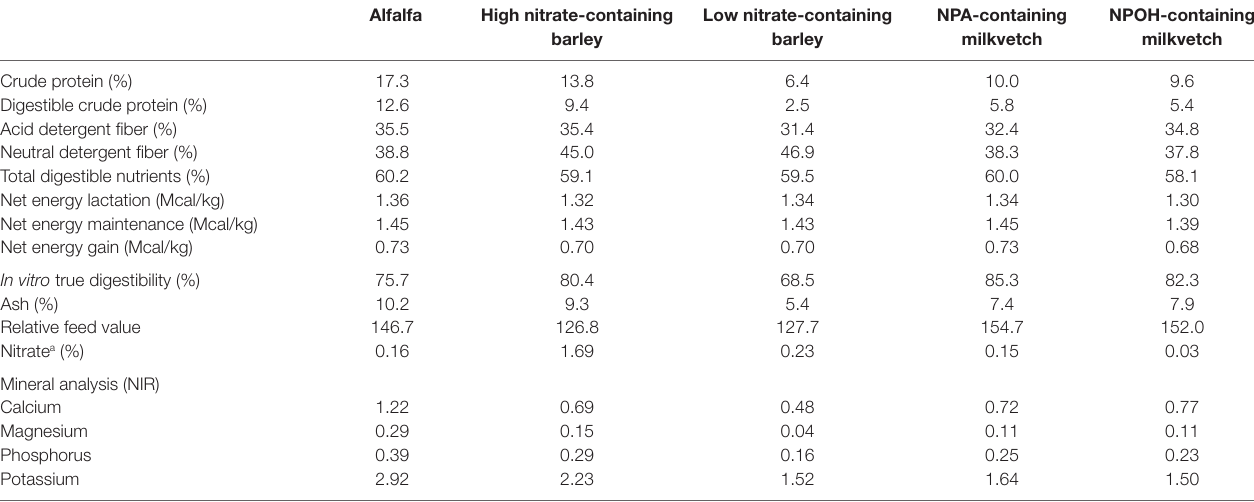
alfalfa high nitrate-containing low nitrate-containing nPa-containing nPOh-containing barley barley milkvetch milkvetch